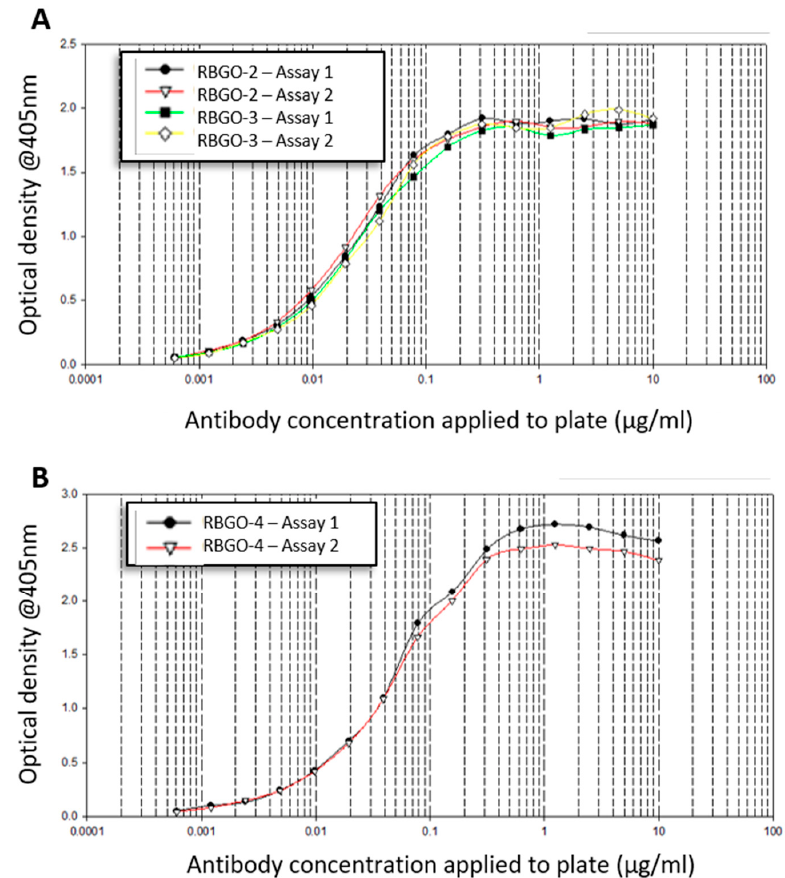
Figure 1. Antibody selection based upon enzyme linked immunosorbent assay (ELISA) against the immunizing peptide. Clones RBGO2 & 3 ( A ) and RBGO4 ( B ) were selected based on a positive ELISA screen using bovine serum albumin (BSA)-conjugated peptides. For ELISA, BSA-conjugated peptides (aa198-217 for RBGO2 and RBGO3; aa327–344 for RBGO4) were immobilized onto micro plates and incubated with two-fold serial dilutions of antibodies. This method represents the standard method of clone selection and good responses to the RBGO2, 3 or 4 antibodies were apparent.